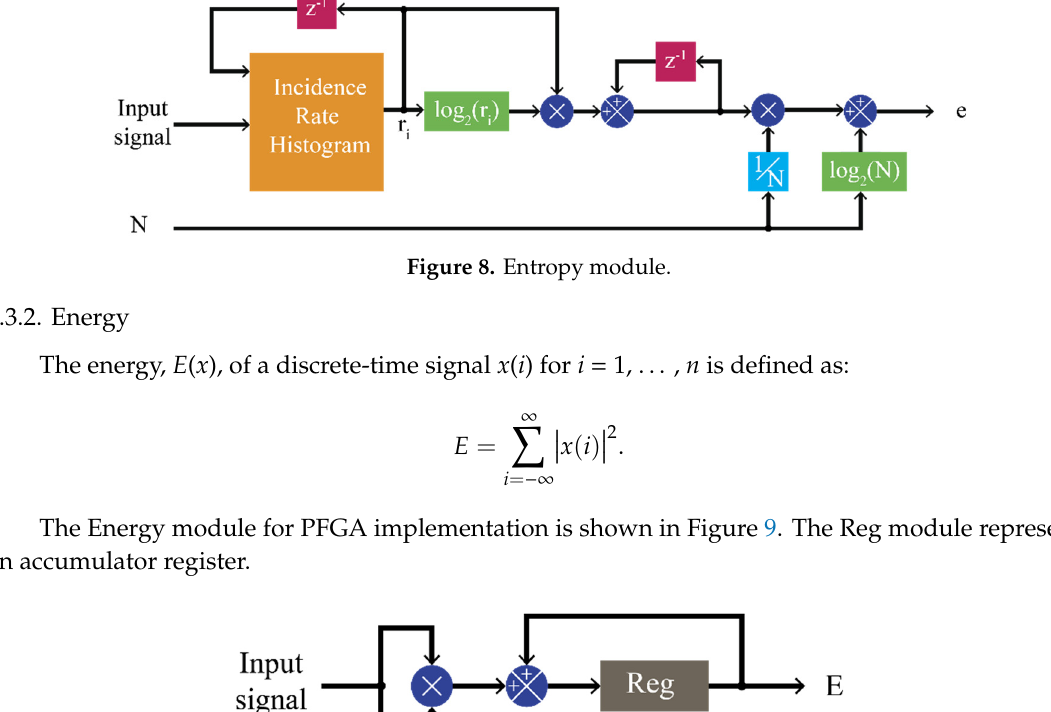
Figure 10. FFNN architecture. FFNN architecture is based on the sum of products between the inputs and their associated weights, plus a bias, which are evaluated by means of a non-linear function for providing the capability of modeling non-linear relationships. To find the network weights, pairs of input–output data are presented; then, a training algorithm is employed to adjust these weights until the error between the desired output and the calculated output is considered acceptable. In this paper the digital structure for a FFNN is previously developed and trained in Matlab and then is implemented on the FPGA. In order to do so, twenty real signals are acquired for each motor condition as described in Section 3. In order to train and validate the FFNN, a dataset of 100 values (70% for training and 30% for validation) for each condition is synthetically constructed (400 values in total, 100 for each condition: HLT, HBB, 1BB, and 2BB). The dynamic range of these values is [ µ − σ , µ + σ ], where µ and σ are the mean and the standard deviation, respectively, for the twenty real signals. The testing set is composed by the real signals only (see later in Section 5.1). The overfitting problem is avoided through the use of both the k -fold cross validation process and three different datasets (one for training, one for validation and one for testing).